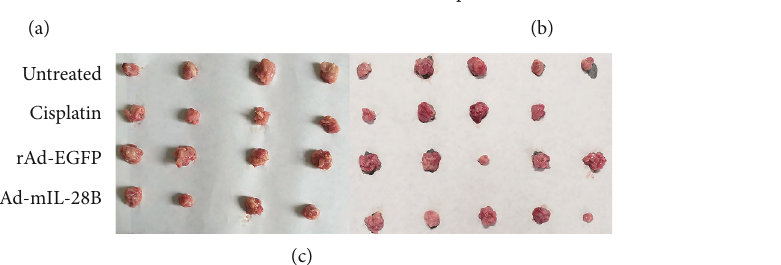
Figure 1: Intratumoral IL-28B gene transfer reduced tumor growth in a subcutaneous H22 hepatoma model. (a) Schema of the experiment was shown. (b) Tumor growth measurements. Data were shown as mean ± standard deviation (SD). ∗ P < 0 : 05 for rAd-mIL-28B vs. rAd-EGFP. (c) Representative image of detached tumors. Data from one experiment, each performed with nine mice, are shown.